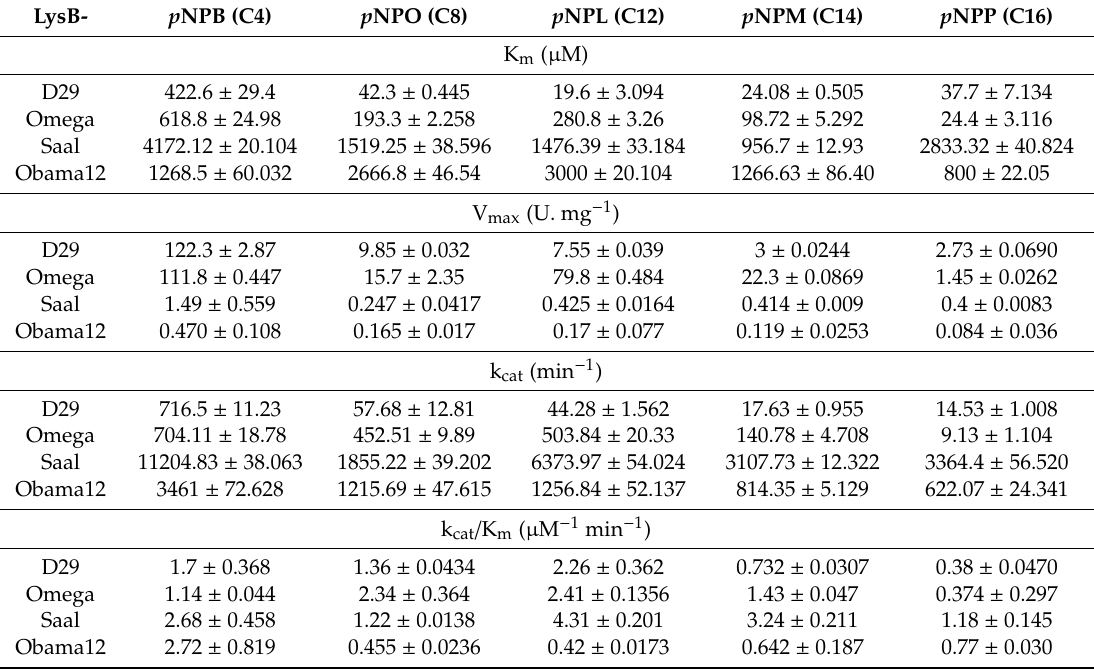
Table 1. Kinetic parameters of Lysin B (LysB)-His 6 enzymes against para -nitrophenyl substrates with di ff erent carbon chain